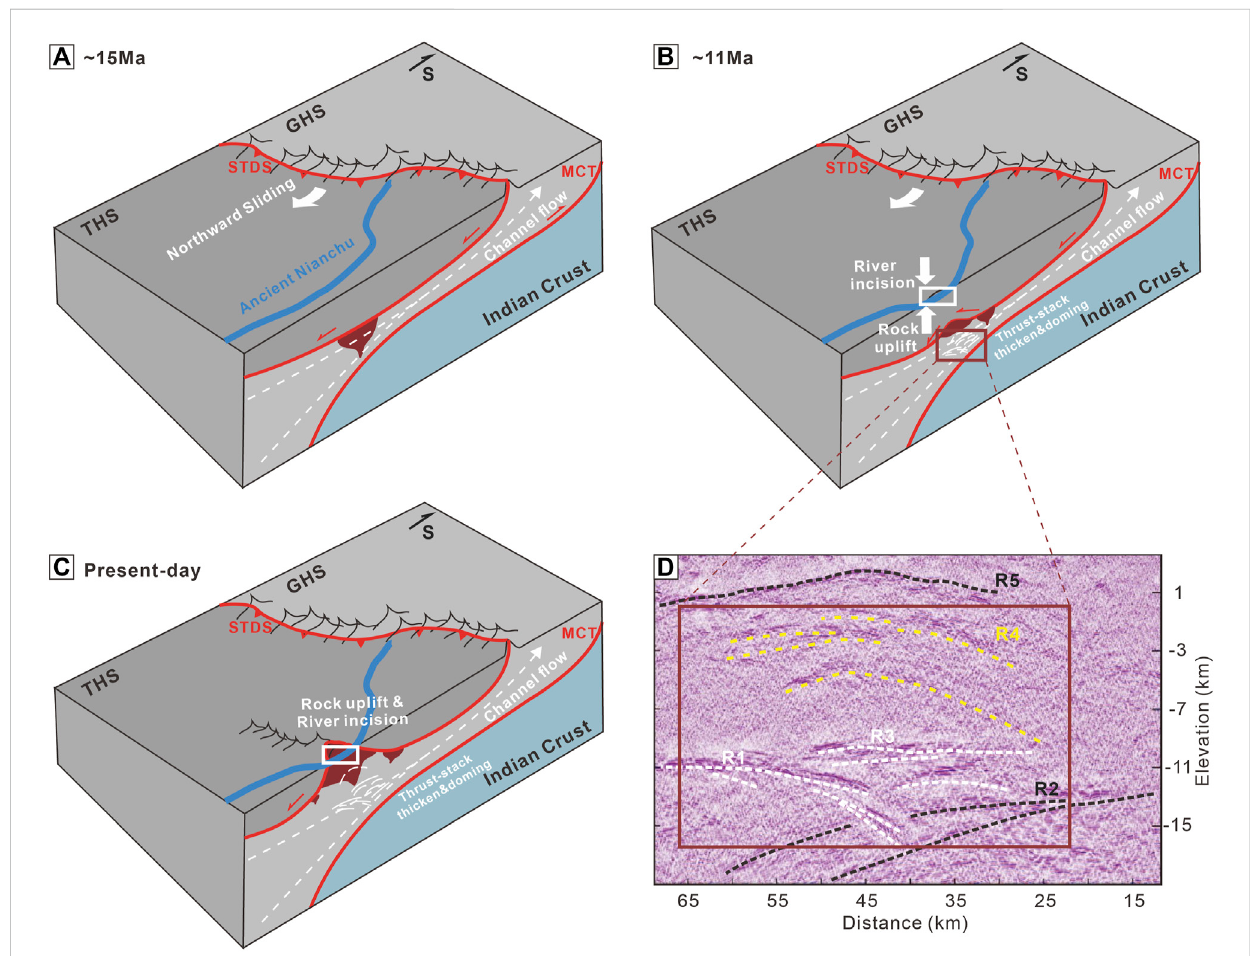
FIGURE 10 Proposed model for the evolution of the Kangmar dome. (A) Top-down-to-N sliding related to the detachment of the STDS and the southward extrusion of the GHC; (B) doming expressed from local crustal thickening caused by stacked thrusts and the associated incision of the Nianchu River. Note that the detachment of the STDS persisted, and the YGR became active at some approximate later time. (C) Continued fast cooling due to glacier activity; (D) interpretation of thedeep seismic re fl ection pro fi le imageby Li etal. (2021). R1-R5 are relatively high re fl ections. R1, R2, and R3 are parts of a thrust decollement, possibly the MCT. R4 represents the consequent doming, and R5 is interpreted to be the STDS shear zone. MCT, Main Central thrust; STDS, Southern Tibetan detachment system; THS, Tethys Himalaya Sequence; GHS, Grater Himalaya sequence; YGR, Yadong-Gulu